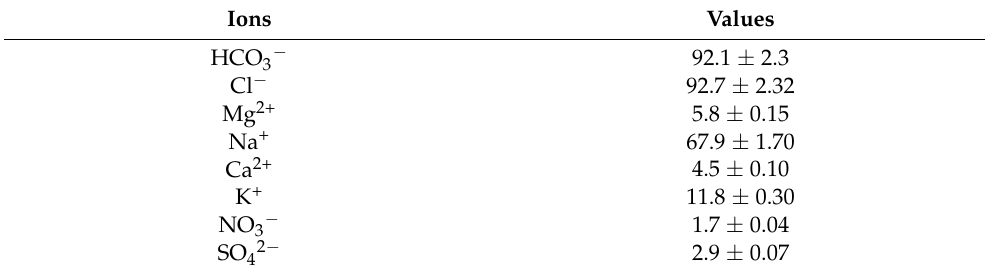
Table 1. Ion concentrations in the water sample, mg/L.